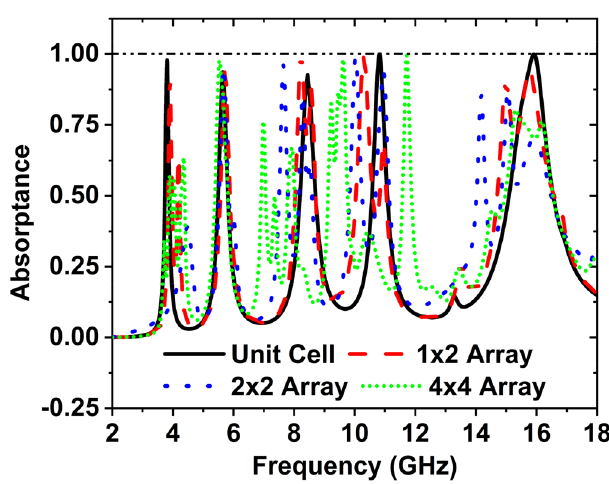
Figure 15. Absorption comparison among different arrays and unit